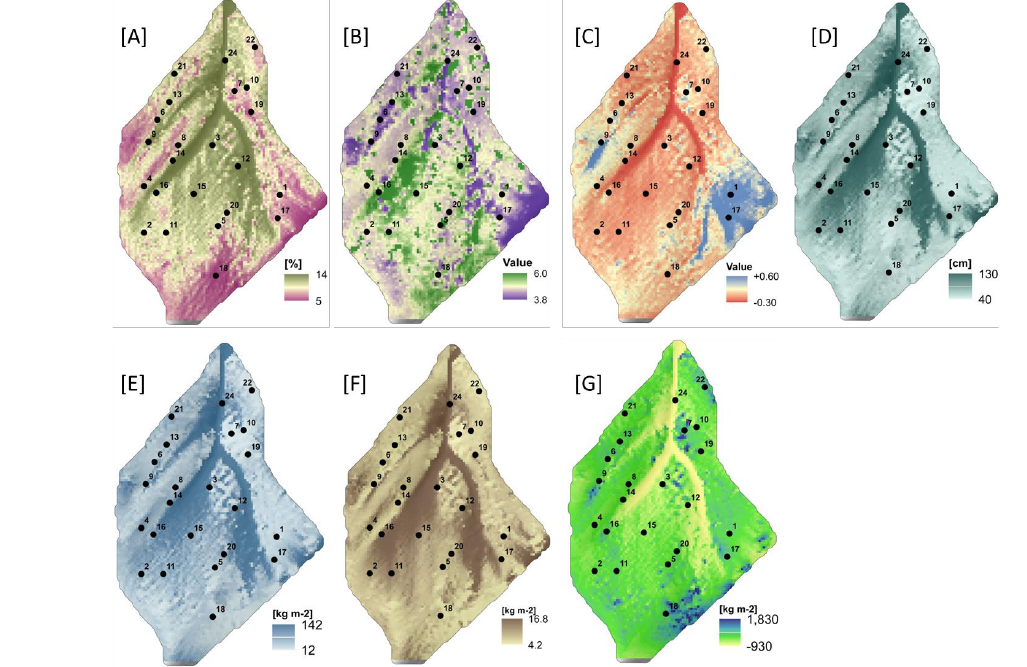
Figure 6. Final maps of predicted soil properties including (a) clay percent, (b) KCl pH, (c) τ Na , (d) soil depth, (e) clay stocks, (f) carbon stocks, and (g) Na mass flux for the study catchment. Final maps are the back-transformed summation of logit-transformed regression estimations and interpolated residuals.